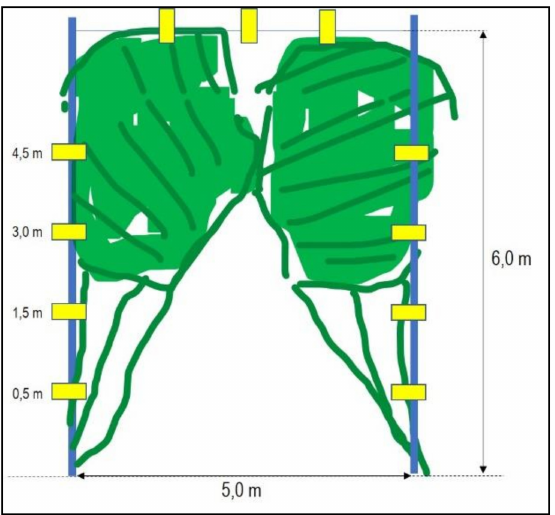
Figure 2. Scheme of the water-sensitive papers’ placement on the hazelnut